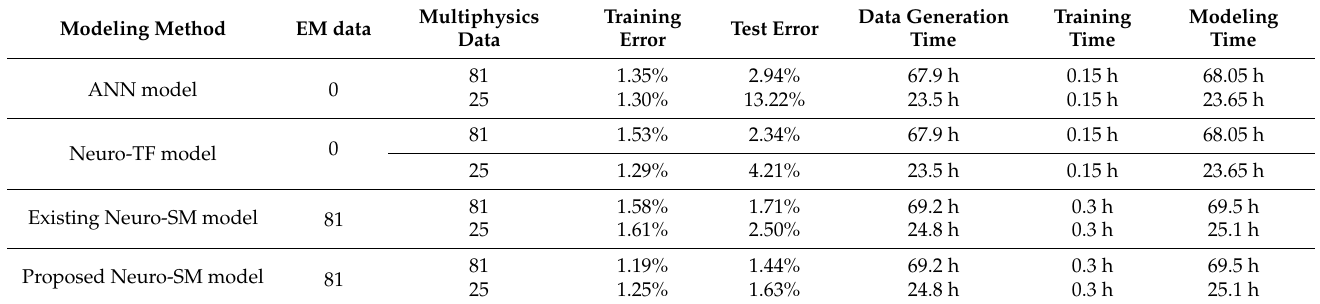
Table 5. Modeling results of four multiphysics parametric modeling methods for the three-pole waveguide